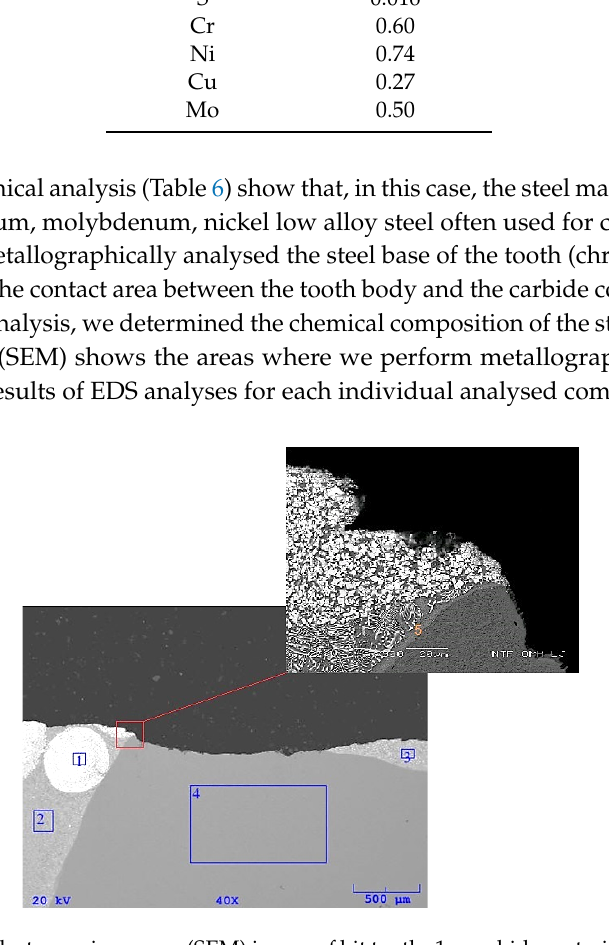
Figure 9. Scanning electron microscope (SEM) image of bit tooth: 1—carbide material, 2 and 3—carbide coating matrix, 4—tooth body, and 5—mixed zone. Table 7. The elemental composition of carbide material (1—Figure 9).